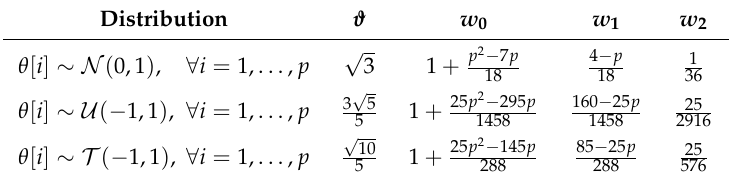
Table 2. PEM parameters according to the standard normal ( N ), uniform ( U ), and triangle ( T ) distribution.